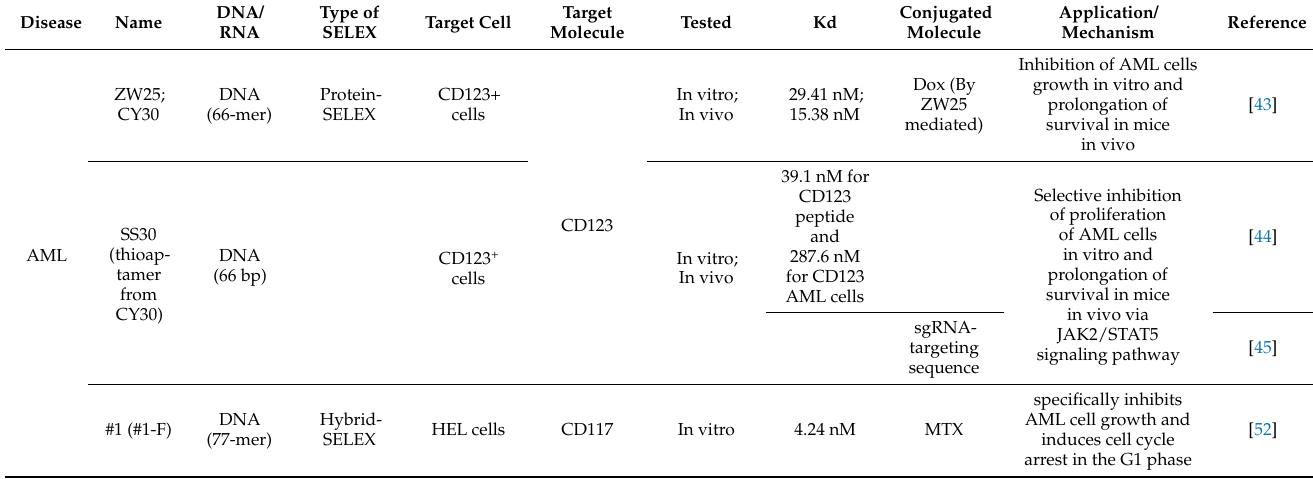
Table 2. Summary of aptamers that have been identified to leukemia. Kd = dissociation